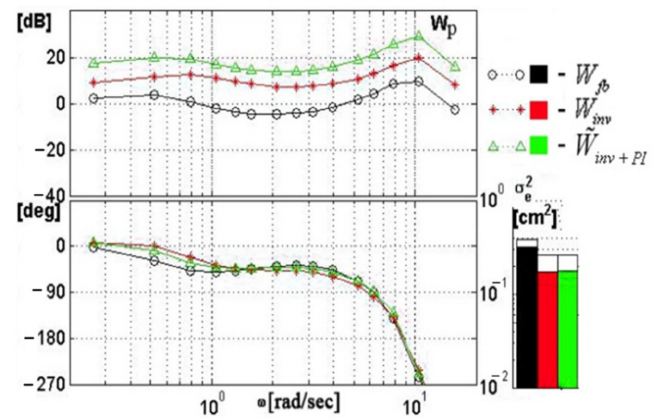
Figure 12. Results of mathematical modeling with uncertainties.